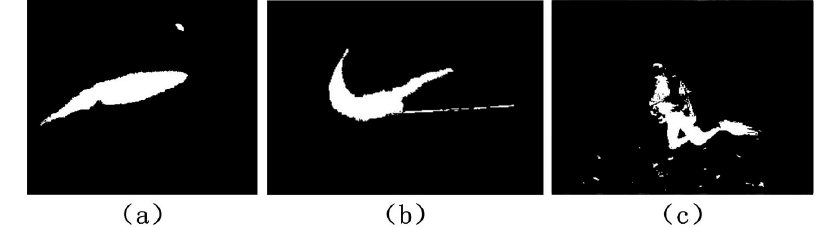
Figure 3. Samples of the object detection. ( a – c ) Results corresponding to the samples in the first, second, and third row of Figure 2, respectively.